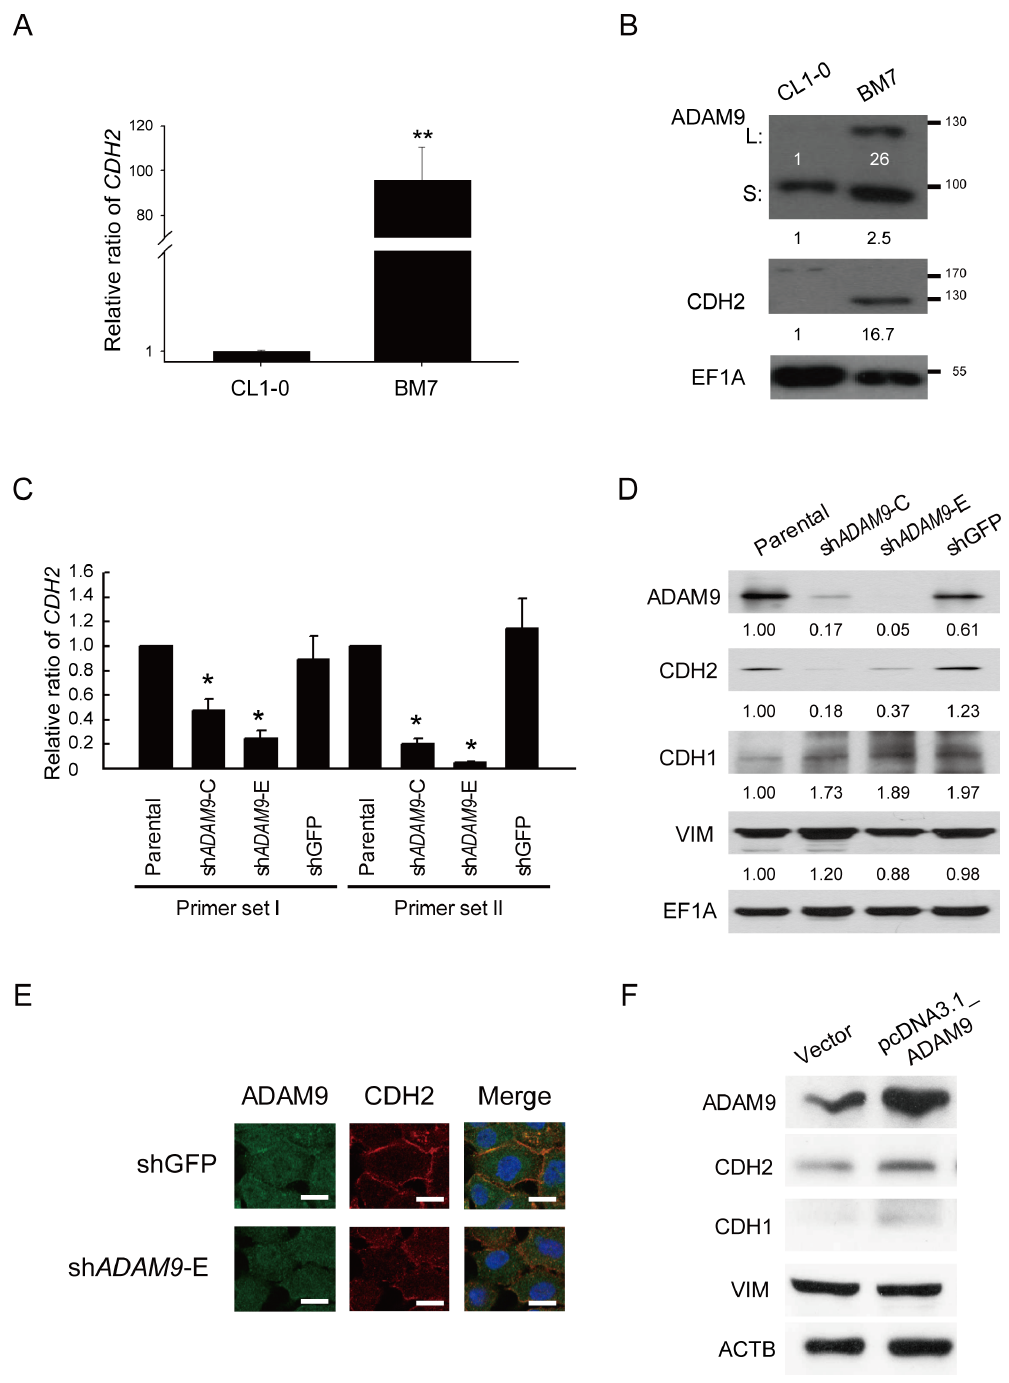
Figure 1. ADAM9 can activate the expression of CDH2 in aggressive lung adenocarcinoma cell lines. (A) Quantitative RT-PCR of CDH2 in the aggressive cell line BM7 and its control line, CL1-0; 18S rRNA was used as a loading control. **, P , 0.005. (B) Western blot analysis of ADAM9 and CDH2 in BM7 and CL1-0 cells. L: long form of ADAM9; S: short form of ADAM9. EF1A was used as a loading control. EF1A: elongation factor 1 alpha. (C) Relative expression levels of CDH2 in BM7 cells transfected with two siRNAs against ADAM9. Two primer sets (I and II) targeting different CDH2 regions were used to amplify the CDH2 products. Two short hairpin RNAs targeted against ADAM9 (sh ADAM9 -C & sh ADAM9 -E) were examined. HPRT was used as a loading control. *, P , 0.05. (D) Western blot analysis of CDH2 in the ADAM9 -depleted BM7 cells. EF1A was used as a loading control. CDH1: E-cadherin; VIM: vimentin. (E) Immunohistochemistry analysis of ADAM9 and CDH2 in the ADAM9 -depleted cells. Scale bar: 20 m m. (F) Western blot analysis of CDH2 in parental cells over-expressing ADAM9 . ACTB was used as a loading control.